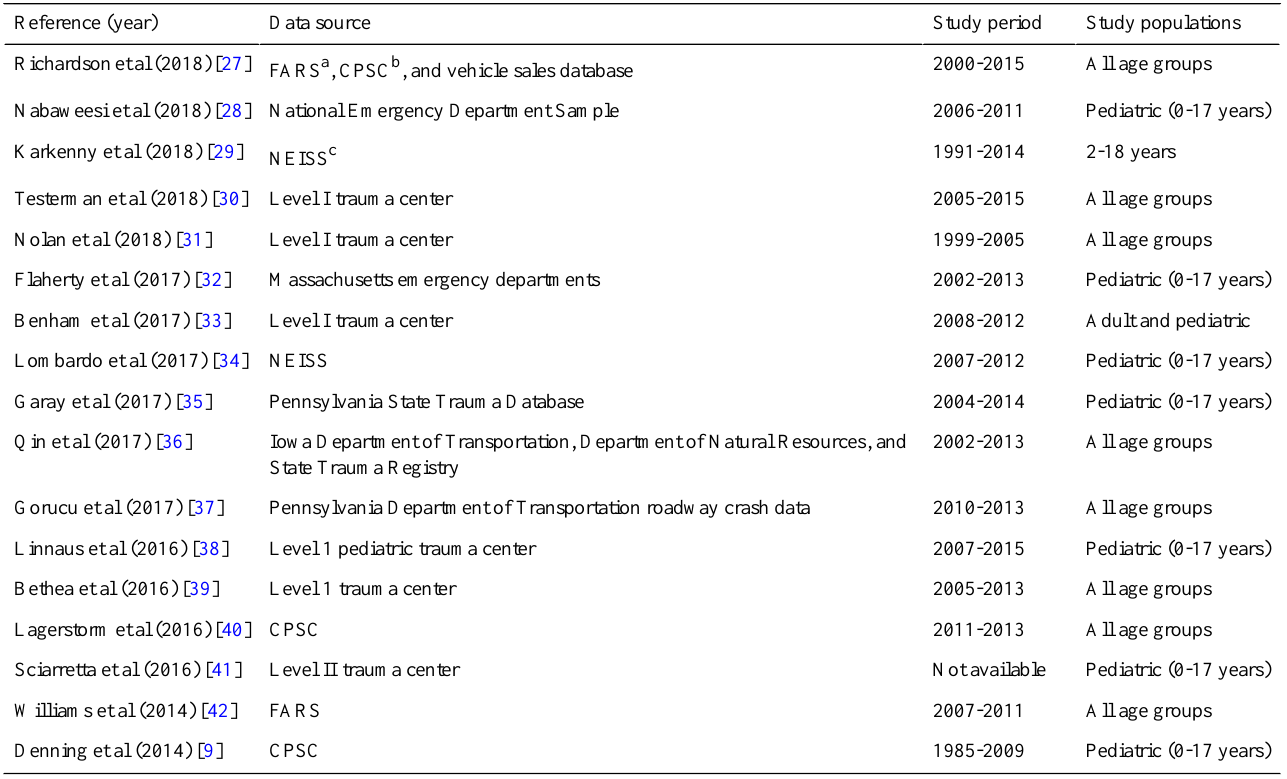
Table 1. Summary of off-road vehicle–related studies (2014-2018) and the data sources